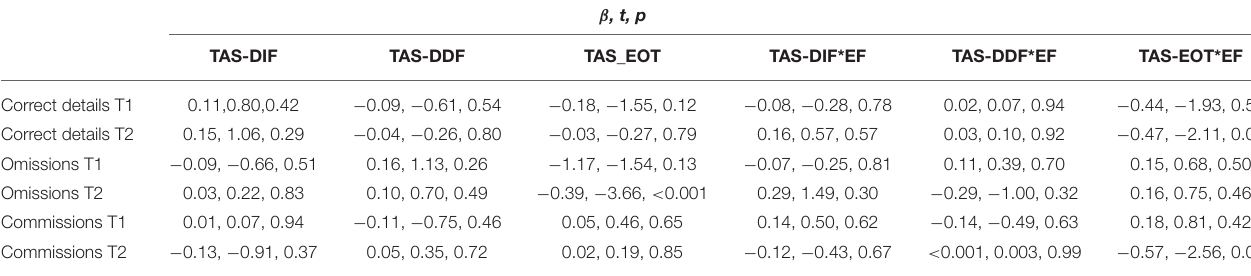
TABLE 3 | Table shows the direct and interaction of effects tested in our General Linear Models on the memory scores.